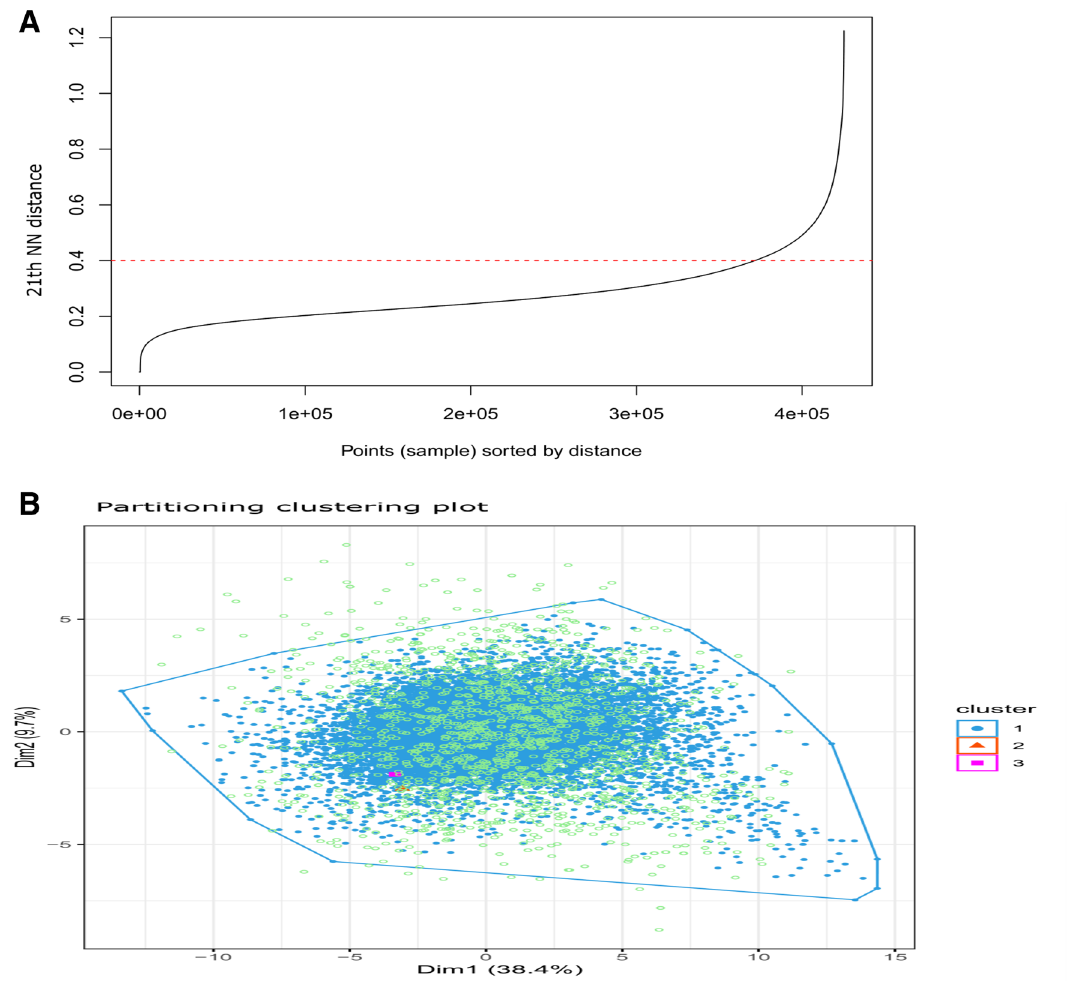
Figure 2. Combined figures of KNN distance plot and Partitioning clustering plot using DBSCAN clustering algorithm for DS vs control (FC neurons). ( A ) KNN distance plot to find knee point ( = 0.4 marked by red dotted line) used as EPS in DBSCAN clustering algorithms for DS vs control (FC neurons). ( B ) Partitioning clustering plot using DBSCAN clustering algorithm for DS vs control (FC neurons). Three clusters had been identified, among which the blue cluster contained 18,148 core (seed) features and 559 border features, the orange cluster had only 10 core features, and the violet cluster consisted of only 5 core features. In addition, a total of 1525 unclustered (outlier/noisy) features (denoted by light green dots) had been